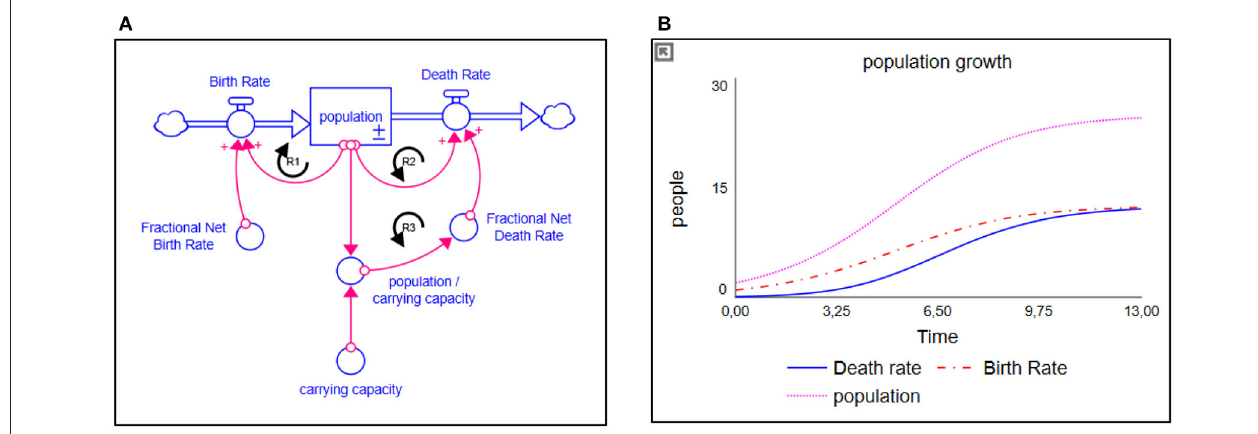
FIGURE 1 | (A) Simplified population model and (B) its respective behavior. The stock is represented as a square; the flows are represented as double-lined arrows. The more people there are, the higher the birth rate is over time; a reinforcing loop (R1). Given a fixed carrying capacity, the more people there are, the more people will die; a counteracting reinforcing loop (R2). If the birth rate remains larger than the death rate, we will experience population growth. Population growth, however, has its limits due to all kinds of factor. Therefore, a balancing structure is built in, indicated by limiting variable “carrying capacity.” The closer the population gets to its respective carrying capacity, the more deaths will occur (a second counteracting reinforcing loop (R3), eventually stabilizing population growth where the amount of deaths equals the amount of births.